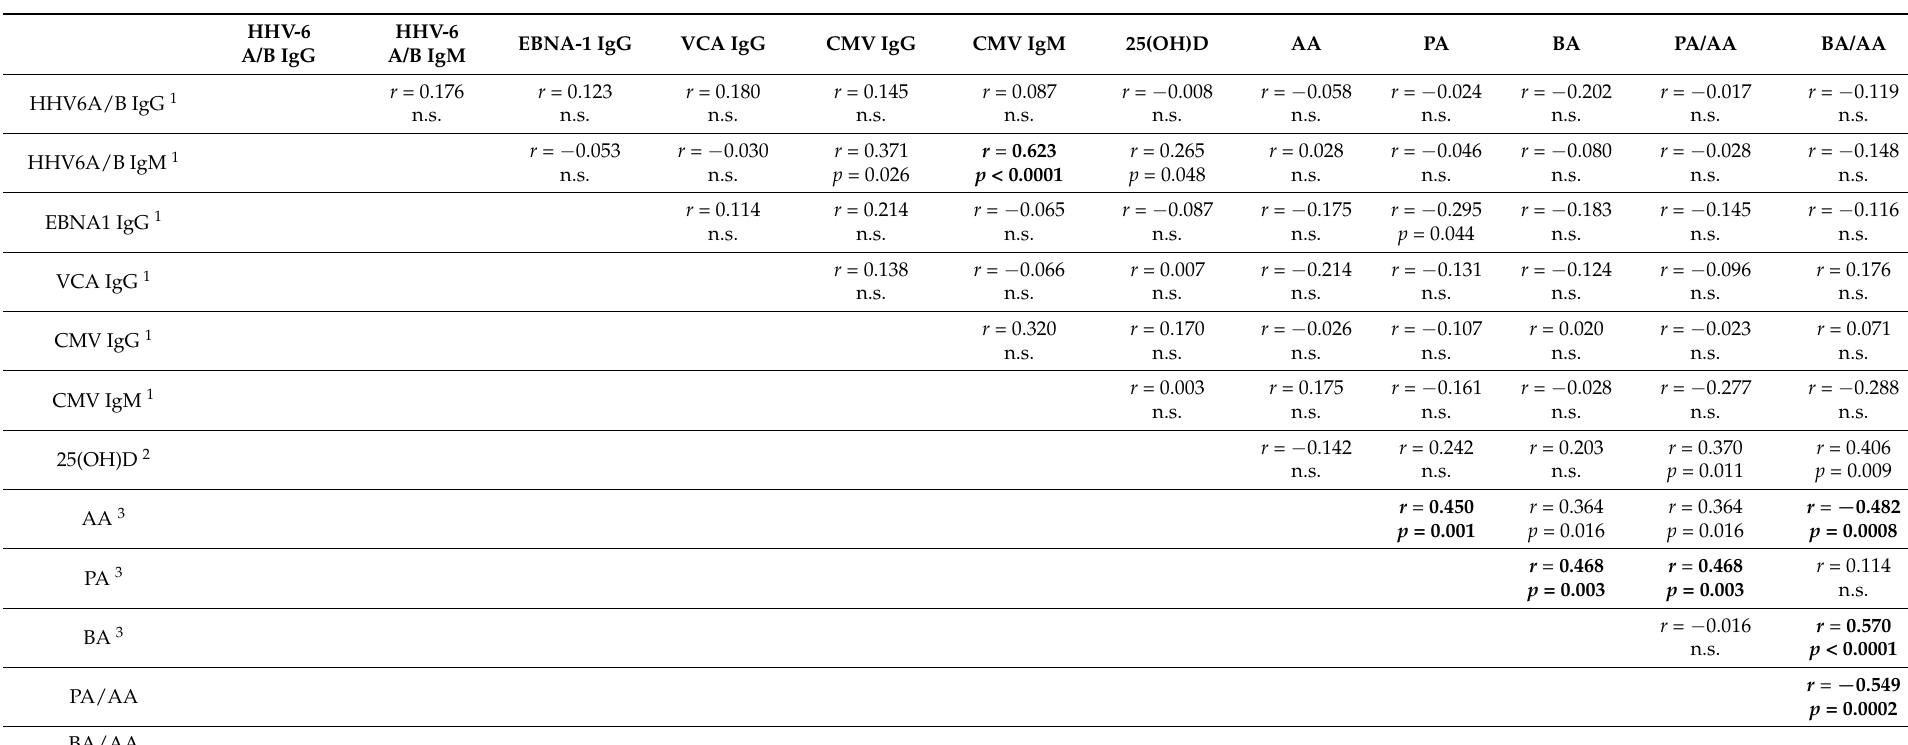
Table 3. Correlations among the environmental factors analyzed in samples collected from healthy